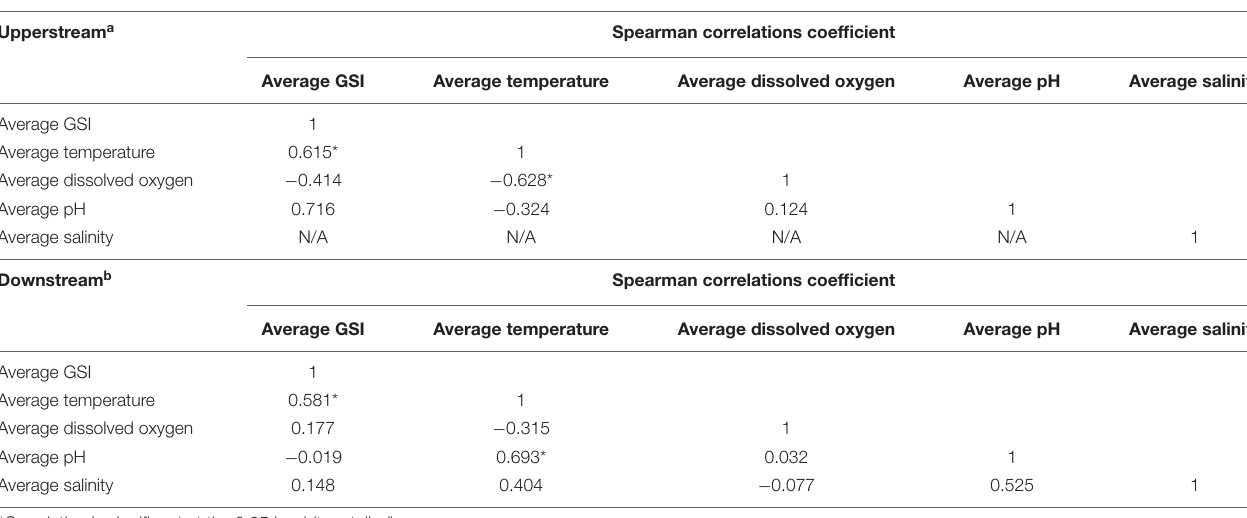
FIGURE 8 | Scatter plot and linear regression for the year-round means of Gonadosomatic index (GSI) of Tenualosa ilisha against mean salinity for two diverse habitats across Bangladesh: (A) Tetulia river, (B) Bay of Bengal. For other four habitats (Kali river, Gaglajur Haor, Padma river, and Meghna river) scatter plot and linear regression was avoided for their observed data recorded of zero salinity. Pearson correlation coefficient is reported as “R” while probability value is reported as “P.” TABLE 2 | Correlation between the upper stream and downstream water quality parameters with GSI of T. ilisha